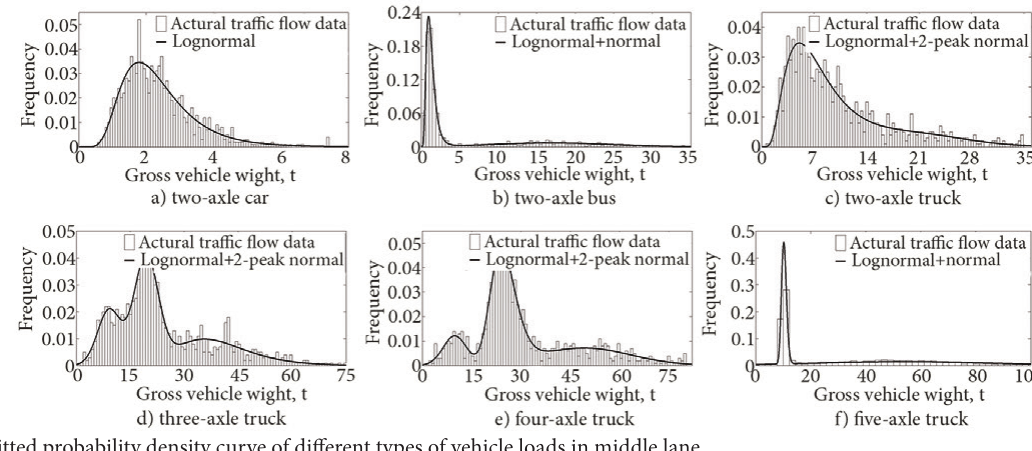
Fig. 4. Fitted probability density curve of different types of vehicle loads in middle lane